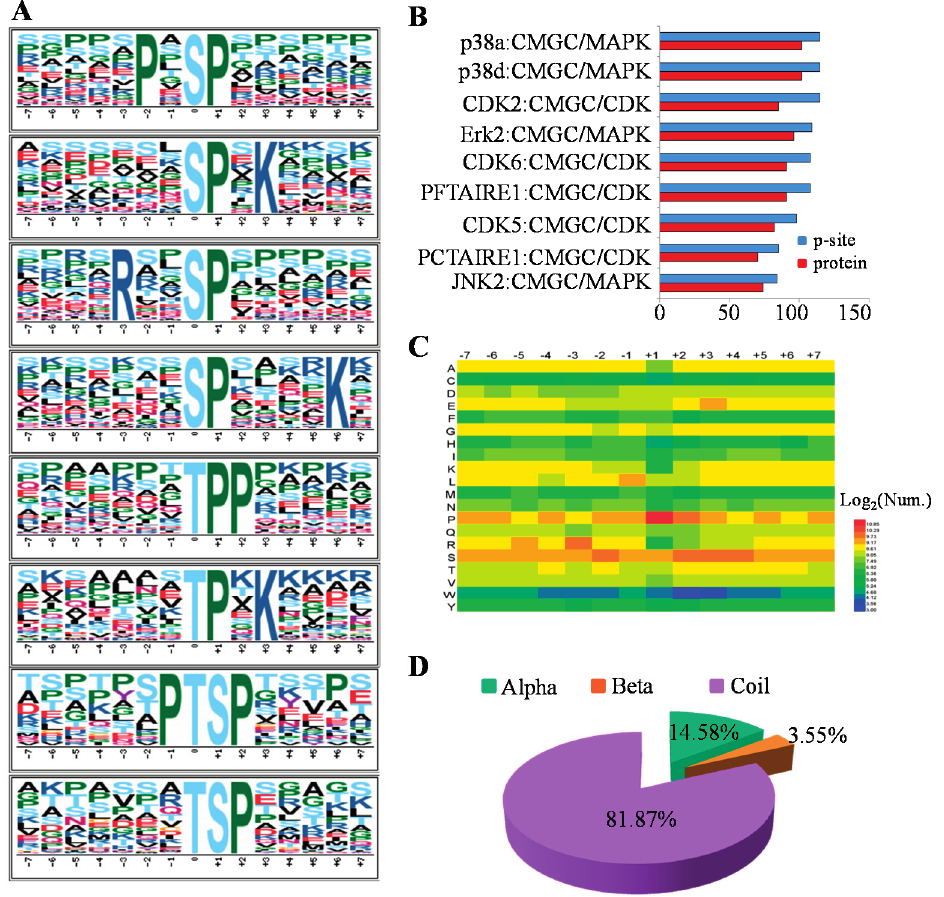
Figure 4. Analysis of p-sites by sequence motif, Group-based Prediction System (GPS) algorithm with the interaction filter, or in vivo GPS (iGPS), the distribution of amino acid flanking and structural preferences in the MHCC97-H cell line. ( A ) The sequence motif analysis of p-sites in the MHCC97-H cell line consisting of 14 residues surrounding the targeted site by Motif-X; ( B ) The top 10 protein kinases with the most p-sites by the prediction of iGPS; ( C ) The heatmap for the distribution of amino acids flanking p-sites in the MHCC97-H phosphoproteome; ( D ) The secondary structural distribution for the p-sites. In order to reveal the corresponding kinases of p-sites, Group-based Prediction System (GPS) algorithm with the interaction filter, or in vivo GPS (iGPS) 1.0 [20], which was developed for